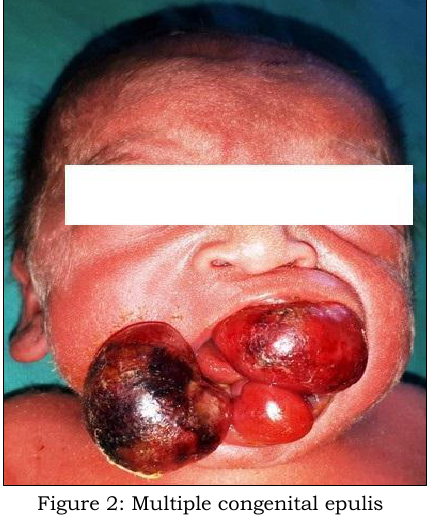
Figure 2: Multiple congenital epulis lesions which have turned reddish-black on day 2 of